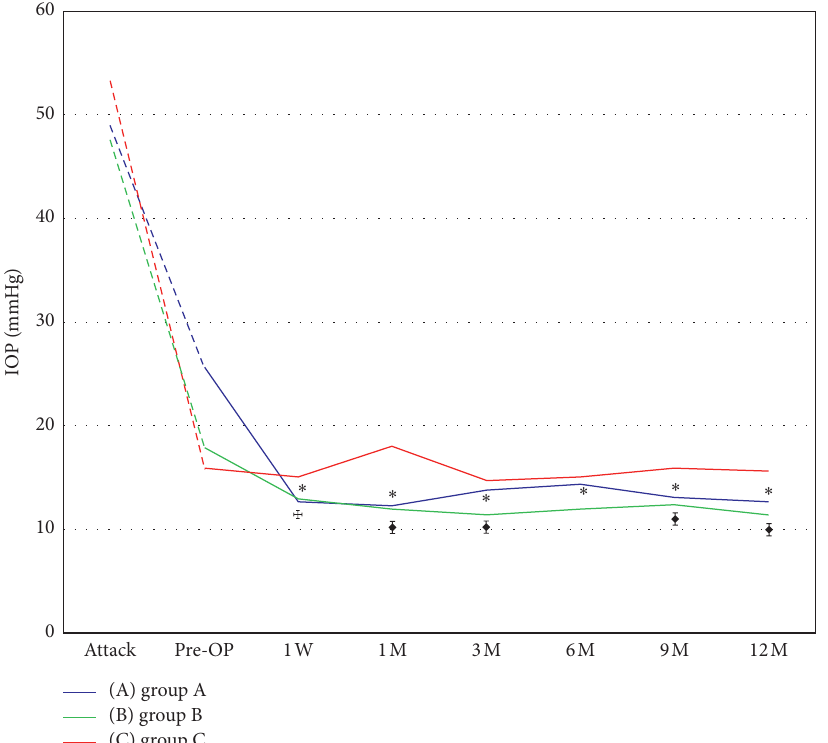
Figure 2: Intraocular pressure changes after operation. Linear mixed model for IOP reduction from baseline (pre-OP) P value < 0.05 between (A) and (B) ☩ ; between (A) and (C) ∗ ; between (B) and (C) . IOP � intraocular pressure, OP � operation, W � week, M �